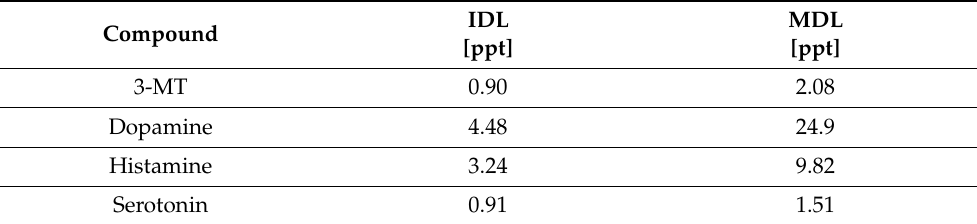
Table 3. In addition, the accuracy and precision of this analytical method are listed in the Supplementary Materials (Table S1). Table 3. IDL and MDL for monoamines.